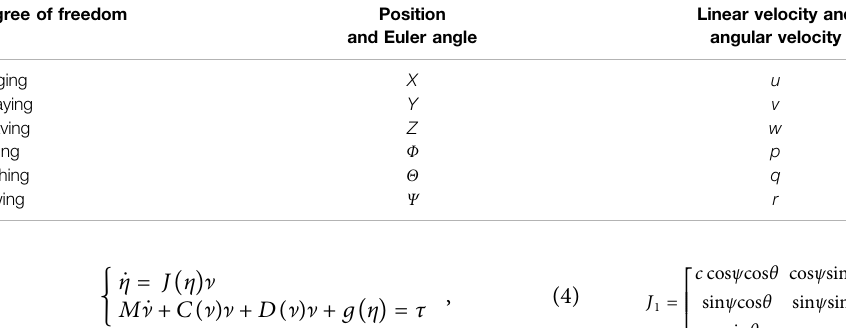
TABLE 1 | Symbolic representation of the AUV model. Degree of freedom Position